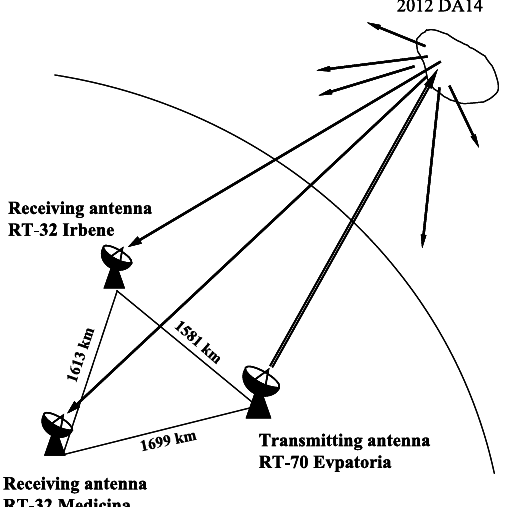
Fig.1. Schematic diagram of the radar VLBI experiment on radio location of the near-Earth asteroid 2012